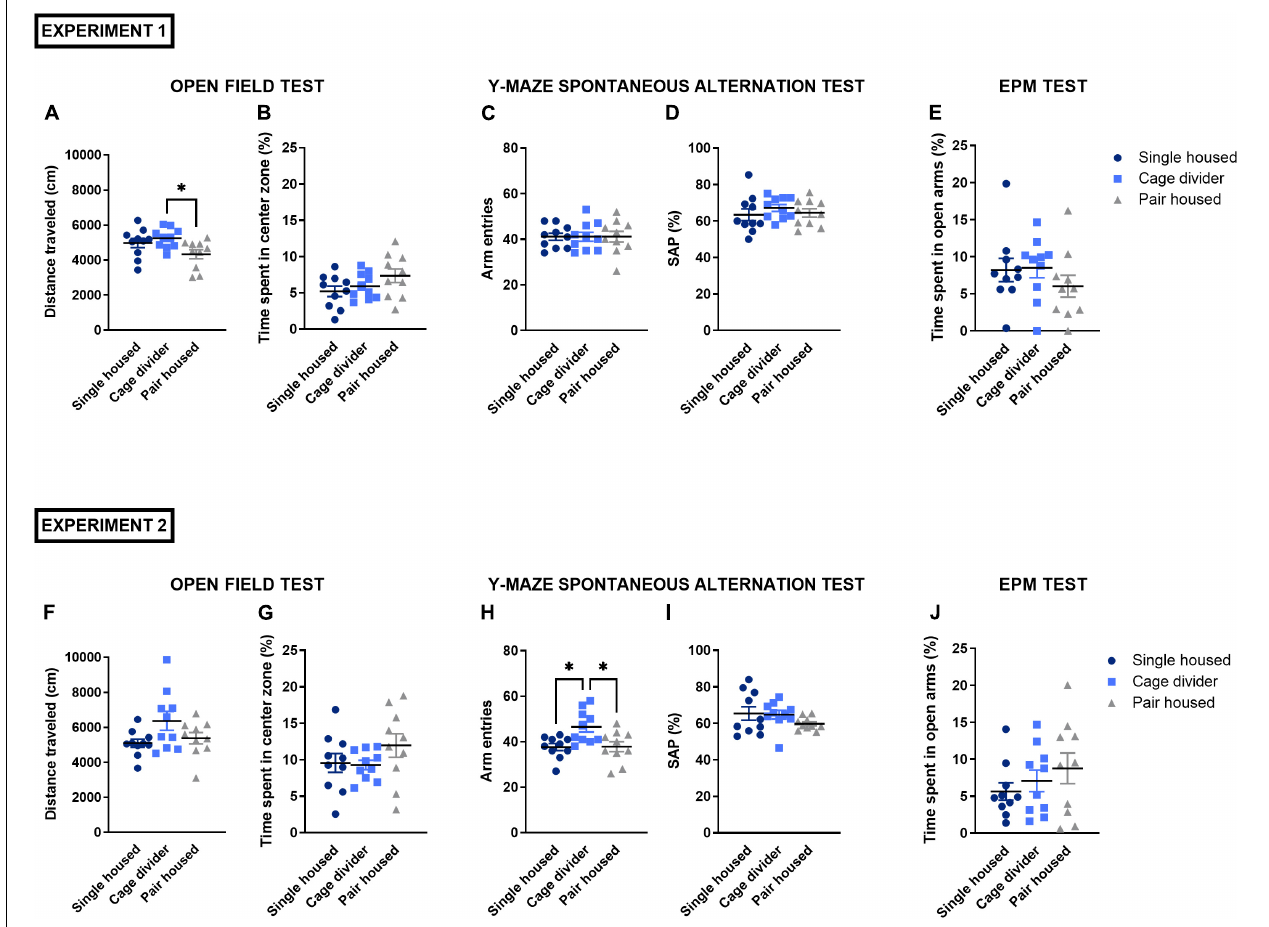
FIGURE 3 | Behavioral testing in mice that are single housed, pair housed and pair housed with a cage divider. (A) Total distance traveled in the OFT (10 min) in experiment 1. (B) Time spent in the center zone of the OFT in experiment 1. (C) Number of arm entries in the Y-maze spontaneous alternation test (8 min) in experiment 1. (D) Spontaneous alternation percentage in the Y-maze test in experiment 1. (E) Time spent in the open arms of the EPM (5 min) in experiment 1. (F) Total distance traveled in the OFT in experiment 2. (G) Time spent in the center zone of the OFT in experiment 2. (H) Number of arm entries in the Y-maze spontaneous alternation test in experiment 2. (I) Spontaneous alternation percentage in the Y-maze test in experiment 2. (J) Time spent in the open arms of the EPM in experiment 2. Data are presented as mean ± SEM. n = 10 mice/housing condition. Statistical analysis: Ordinary One-way ANOVA with Tukey’s multiple comparisons test for comparisons between single housed, pair housed and mice housed with a cage divider. ∗ P < 0.05. OFT, open field test; EPM, elevated plus maze test; SAP, spontaneous alternation